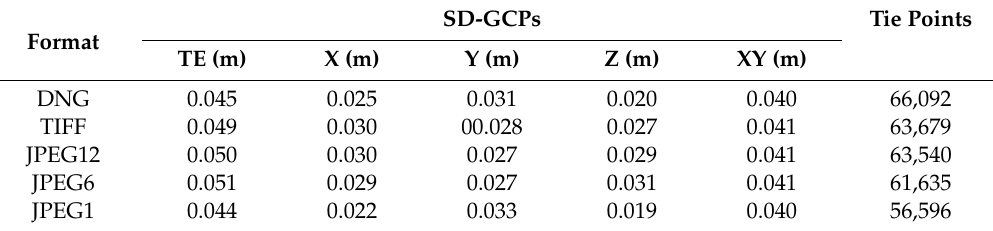
Table 4. Evaluation of the accuracy on GCPs and number of tie points—Test site 2.